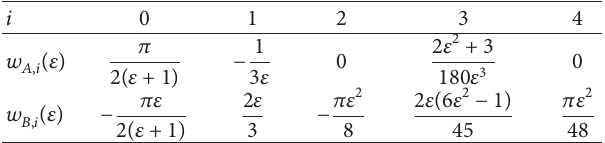
Table 2: The coefficients 𝑤 𝐴,𝑖 (𝜀) and 𝑤 𝐵,𝑖 (𝜀) appearing in (107) and